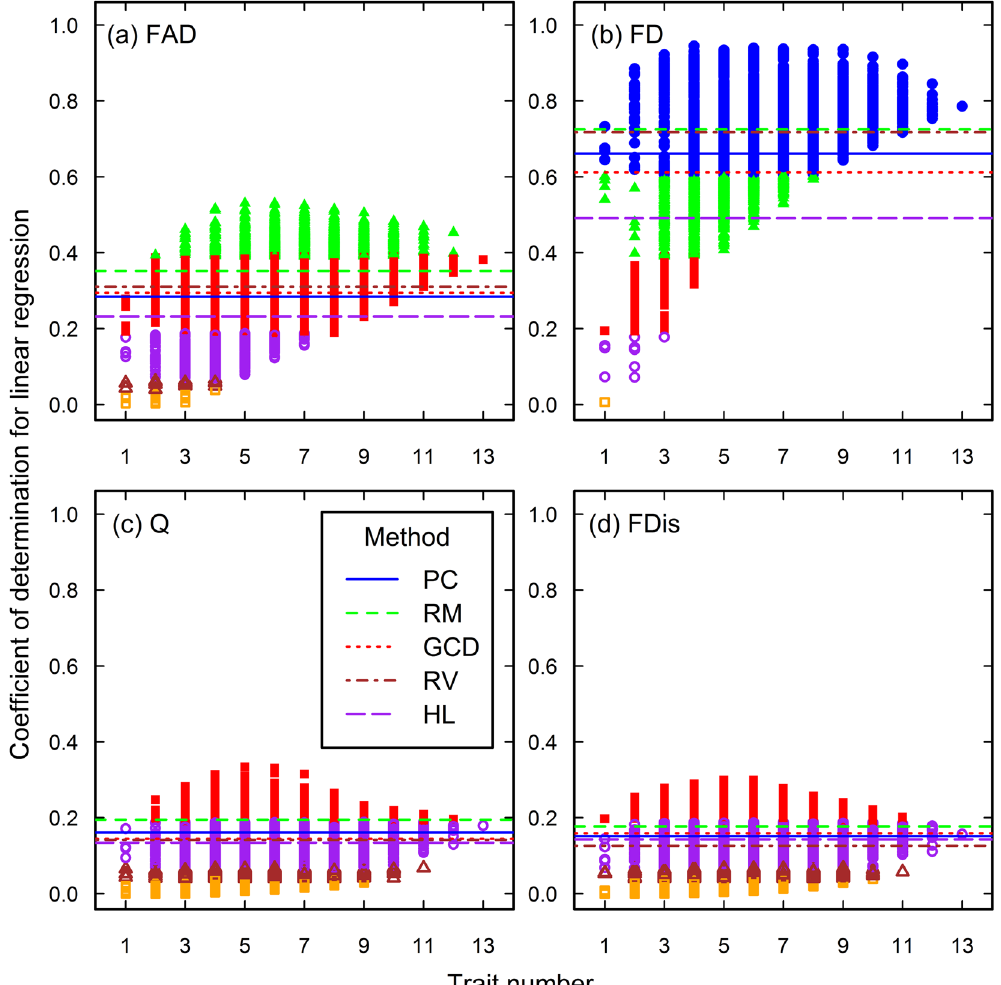
Figure 2. The closeness of associations between species richness and functional diversity in the Loess Plateau data set. The four functional diversity indices, FAD ( a ), FD ( b ), Q ( c ), and FDis ( d ), were calculated using different numbers and identities of traits. Each line in the plots donates the closeness of associations between species richness and one functional diversity index calculated using one subset of traits, which were determined using one of the methods, PC (principal components), RM (RM coefficient), GCD (Yanai’s Generalized Coefficient of Determination), RV (RV coefficient), and HL (the highest loads). One point in each plot represents the closeness of the association calculated using one trait combination in the analysis of the complete search. The points with different colors and symbol represent different levels of P values. Filled and blue circles, P ≤ 1.0 × 10 − 20 ; filled and green triangles, 1.0 × 10 − 20 < P ≤ 1.0 × 10 − 11 ; filled and red squares, 1.0 × 10 − 11 < P ≤ 1.0 × 10 − 5 ; open and purple circles, 1.0 × 10 − 5 < P ≤ 0.01; open and brown triangles, 0.01 < P ≤ 0.05; open and orange squares, P >